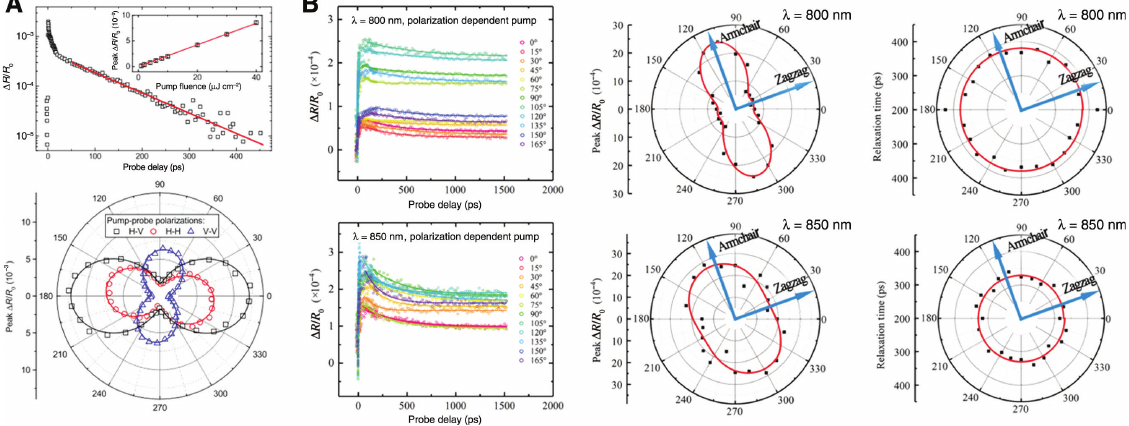
Figure 5: Time-resolved differential reflection signal from BP and SnSe samples and its angular dependence. (A) BP. Top figure: the measured differential reflection signals as a function of probe delay (the red line indicates the fitting with a time constant of ~ 100 ps, and the inset shows the peak signal against the pump influence); bottom figure: the peak differential reflection signals as a function of angle with the pump-probe polarization orientation of horizontal–vertical (H–V), horizontal–horizontal (H–H), and vertical– vertical (V–V), respectively. Reproduced with permission from He et al. [98]. (B) SnSe. The measured differential reflection signals as a function of probe delay at 800 and 850 nm; the corresponding polar plots of the peak differential reflection signals and carrier relaxation time. Reproduced with permission from Zhang et al.